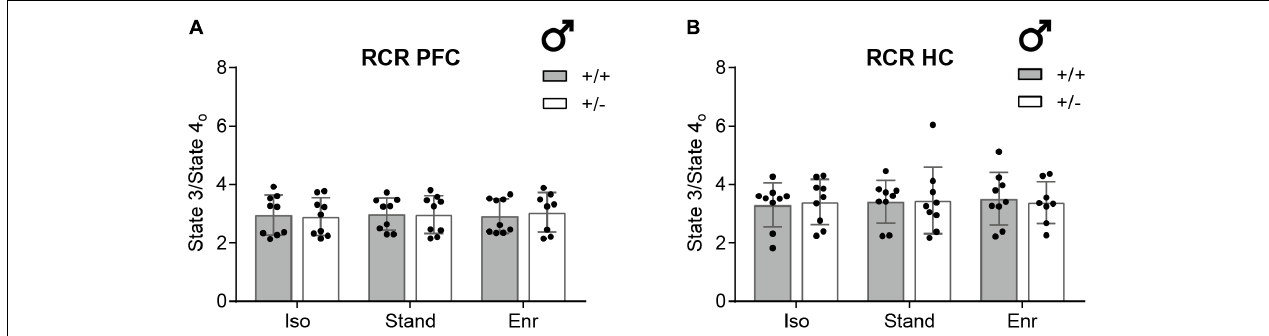
FIGURE 5 | Respiratory control ratio (RCR) as indicator for mitochondrial integrity. The RCR was determined from isolated mitochondria of (A) the right prefrontal cortex and (B) the right hippocampus of 2-month-old male Cacna1c + / − rats and Cacna1c + / + littermate controls which were each kept in one of the three different environmental conditions. The State 3 to State 4 o ratio (RCR) is a measure of the coupling quality between respiration and phosphorylation (mean ± SD, n = 8–9). PFC, prefrontal cortex; HC, hippocampus; + / +, wildtype Cacna1c + / + (gray bars); + / − , heterozygous Cacna1c + / − (clear bars); Iso, isolation; Stand, standard housing; Enr, enrichment.